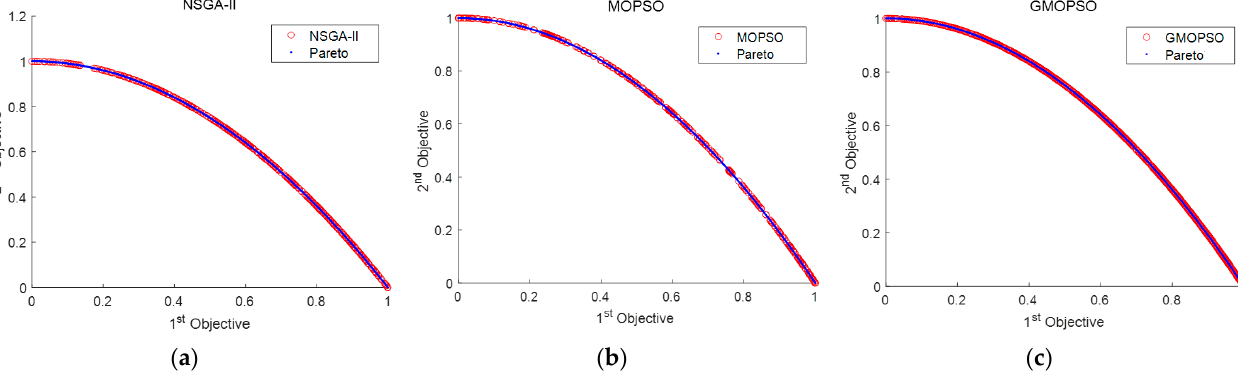
Figure 5. Test results of function ZDT2. ( a ) Pareto solutions of NSGA-II; ( b ) Pareto solutions of MOPSO; ( c ) Pareto solu- tions of GMOPSO.